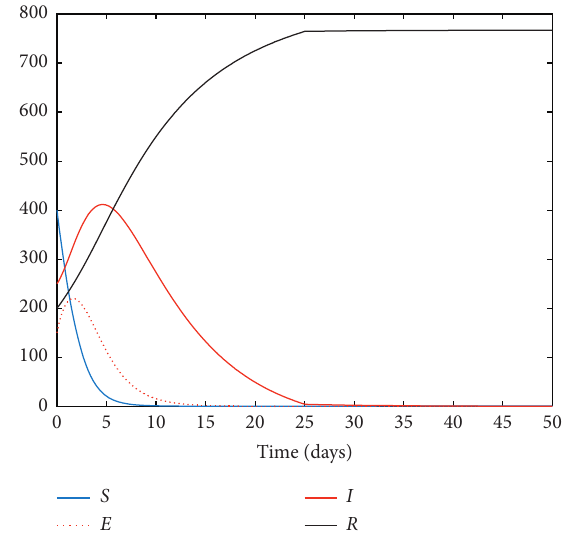
Figure 6: Evolution of the populations with the nonnegative control actions and n � 25